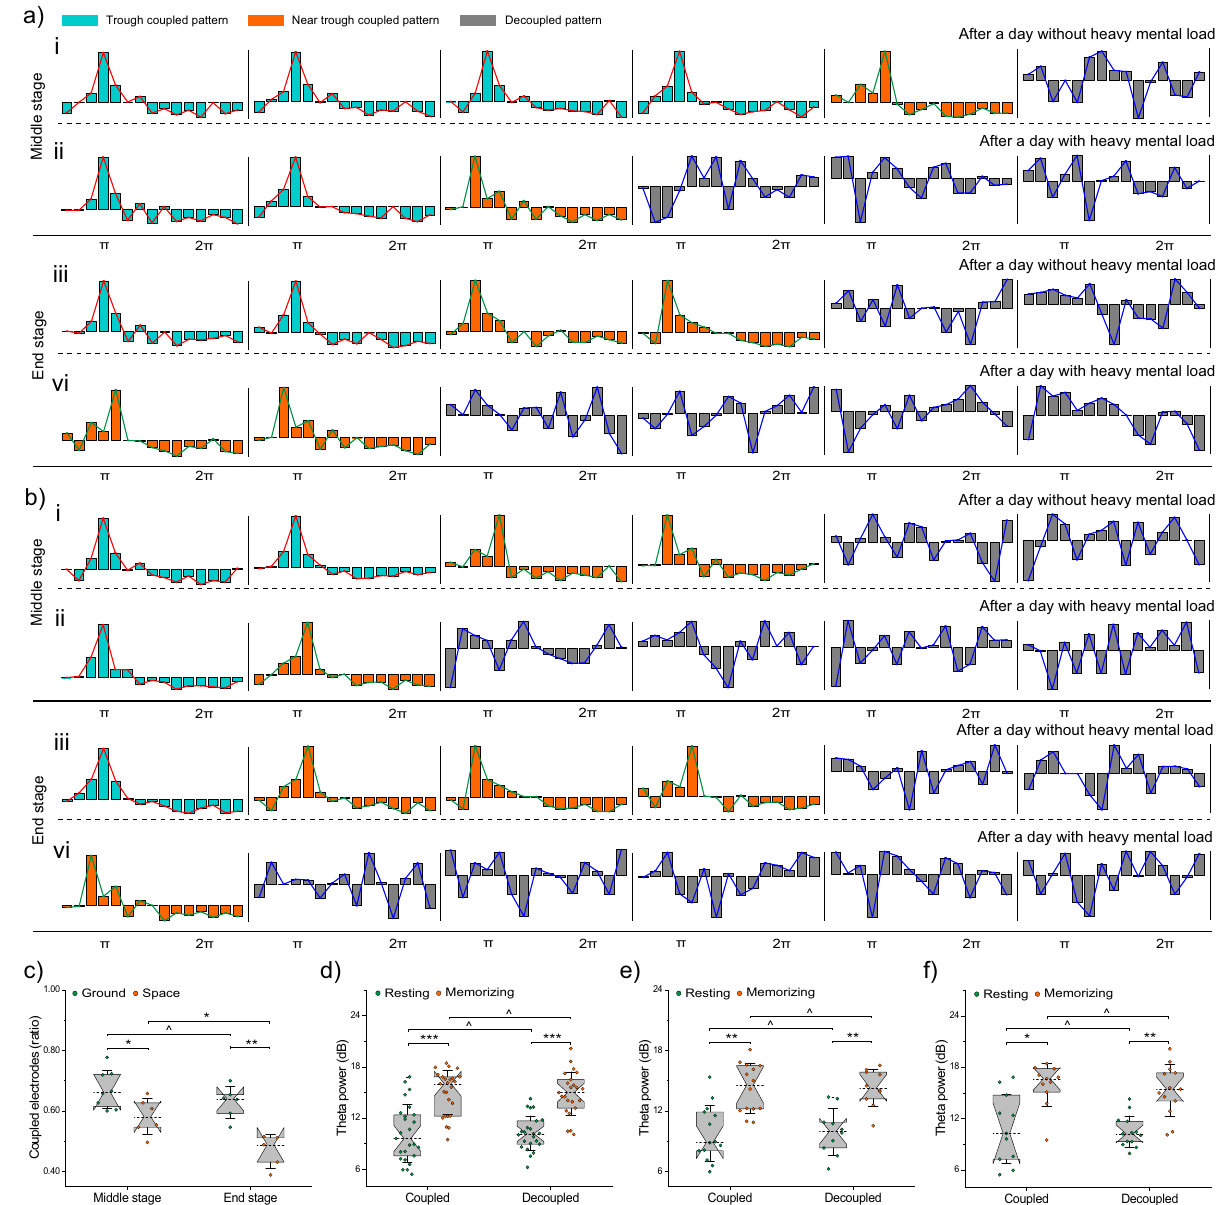
Fig. 5 Test results of astronauts. a and b Show the theta-gamma phase-amplitude coupling (PAC) or decoupled PAC of astronauts on the ground and the space station, respectively. Cyan bars indicated that averaged gamma amplitudes were locked at the trough of the theta cycle. Orange bars indicated that averaged gamma amplitudes burst near the trough of the theta period. Grey bars showed that the coupled phase of the trough or near the trough disappeared. (i) and (ii) Panel show tested results in the middle stage after a day without heavy mental load and with heavy mental load, respectively. (iii) and (iv) panel show tested results in the end stage after a day without heavy mental load and with heavy mental load, respectively. c Green dots and orange dots show the ratio of coupled electrodes in the middle ( n = 8 vs. n = 6) and end ( n = 6 vs. n = 5) stages, respectively. Data is shown by means ± standard deviations. Whether the ratio was signi fi cantly changed, indicated by the one-way ANOVA (^ p > 0.05, * p < 0.05, ** p < 0.001). d Green dots and orange dots show the averaged theta wave activity (TWA) of the resting and memorizing conditions in coupled group ( n = 25), respectively. Data is shown by boxplot. The whisker threads in both ends of the boxplot represent standard deviations, and dashed lines in the middle of the boxplot represent medians. TWA of memorizing condition was signi fi cantly higher than that of the resting condition, indicated by the paired-sample t -tests of two-tailed (* p < 0.05, ** p < 0.001, *** p < 0.0001). When the theta-gamma PAC was decoupled ( n = 23), TWA was not signi fi cantly different (^ p > 0.05). Data of astronauts (couped n = 14 vs. decoupled n = 10) before space fl ight are shown in fi gure ( e ) Data of astronauts (couped n = 11 vs. decoupled n = 13) in space fl ight are shown in fi gure ( f multiple cortical areas. A study by Daume et al. 61 suggested an contrast, our data revealed abundant local PAC inside the bilat- alternative mechanism by which frontal theta waves might con- eral temporal-parietal, occipital-parietal, or central-parietal cor- trol fast oscillatory activity in posterior brain regions during tices, while only FCC and TPC interregional PAC decoupled after visual WM, and local coupling between theta phase and gamma the lengthy mental task. We speculate that the gating mechanism amplitudes was observed in the inferior temporal cortex. In outlined above is relatively vulnerable in WM processes;